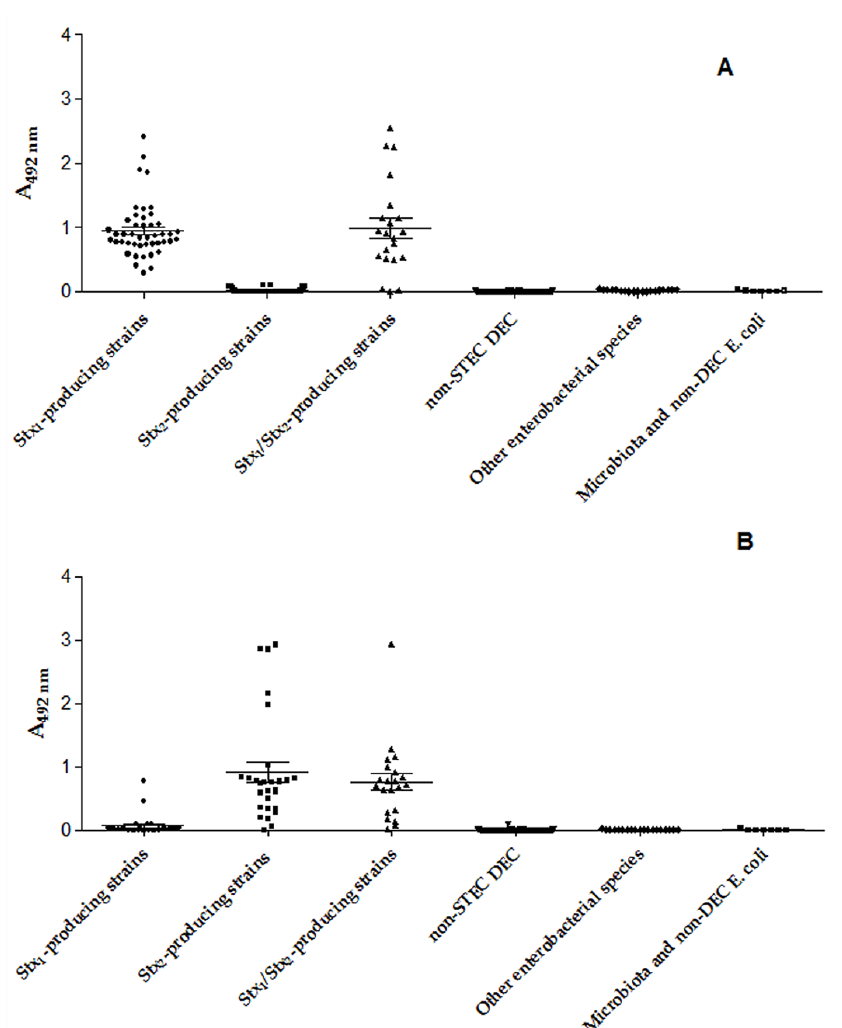
Figure 6. Capture ELISA (cEIA) analysis: ( A ) Employing Stx 1 pAb and mAb; ( B ) Employing Stx 2 pAb and mAb. The optical densities obtained for the isolates reacted with Stx 1 , or Stx 2 pAb and mAb were analyzed by GraphPrism 5.01, using the Student’s t-test and two-way ANOVA. The differences were considered statistically significant when p ≤ 0.05.